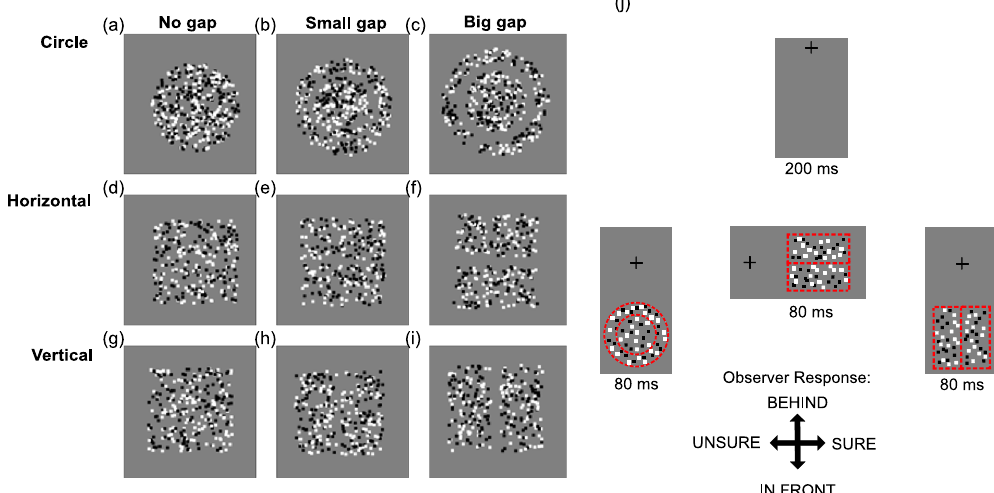
Figure 6. ( a ) Schematic of stimuli used for each condition. ( a ) For the circular condition, the target was always the inside circle. ( b ) For the horizontal condition the target was always the top rectangle and ( c ) for the vertical condition the target was always the right rectangle. The task in each case was to identify whether the target was behind or in front of the reference. Participants were required to stay fixated on the cross at all times. ( b ) Participants were required to indicate for each presentation whether the target was in front of or behind the reference, immediately after which a confidence decision (sure or unsure) was required. The procedural schematic shows a border to separate target and reference, and the relative location of the fixation cross for information